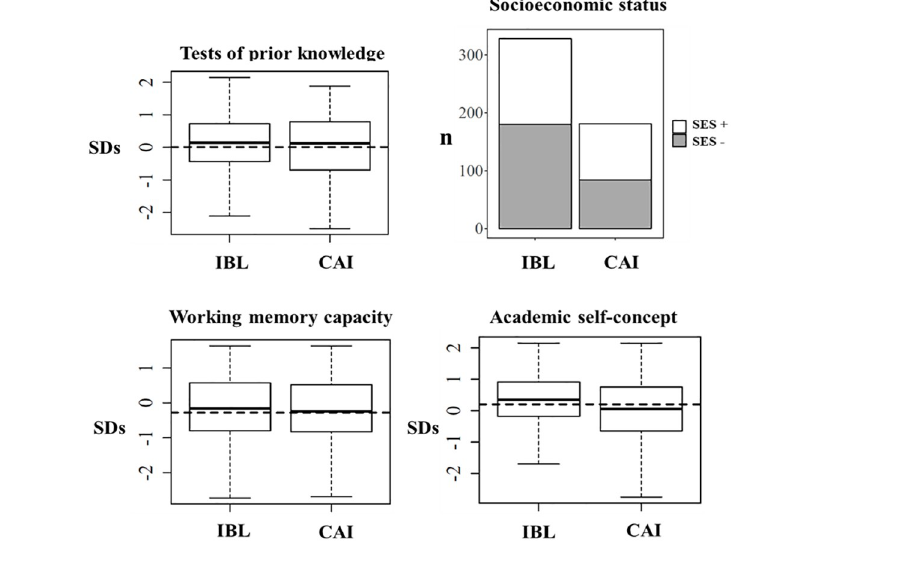
Fig 3. Pre-test imbalance analysis for measures of prior knowledge, socioeconomic status, working memory capacity and academic self-concept.